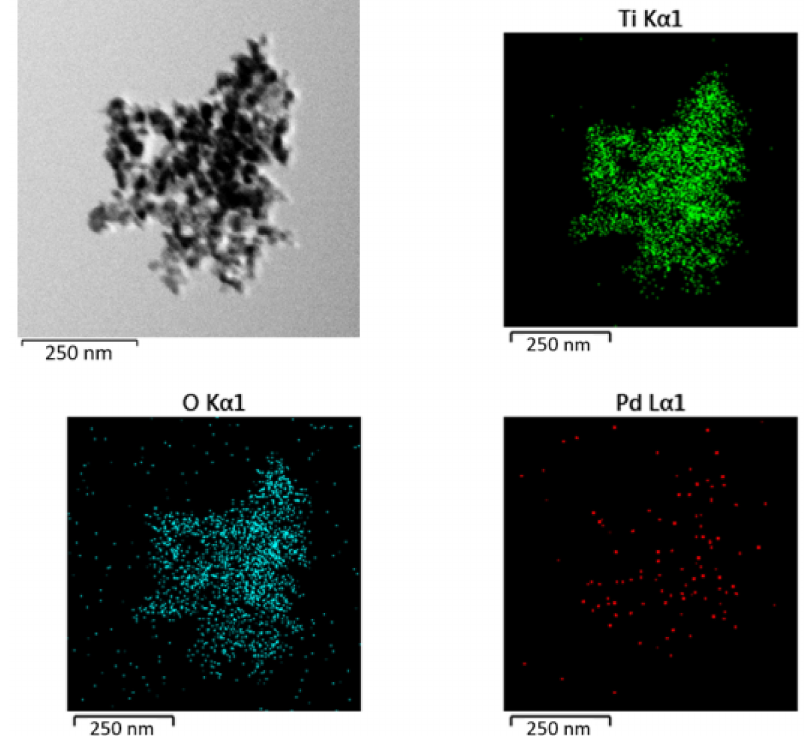
Figure 4. EDS element mapping image of Pd/TiO 2